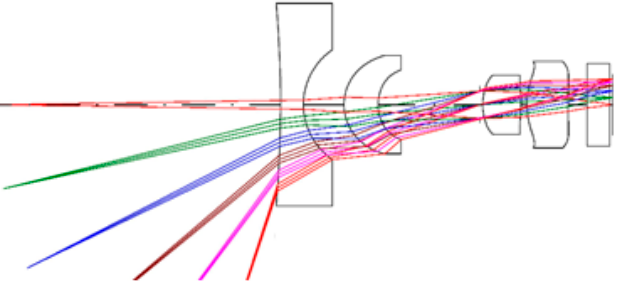
Figure 1. Schematic diagram of a 2 × zoom lens design with a glass spherical lens and three plastic aspheric lenses in sequence.